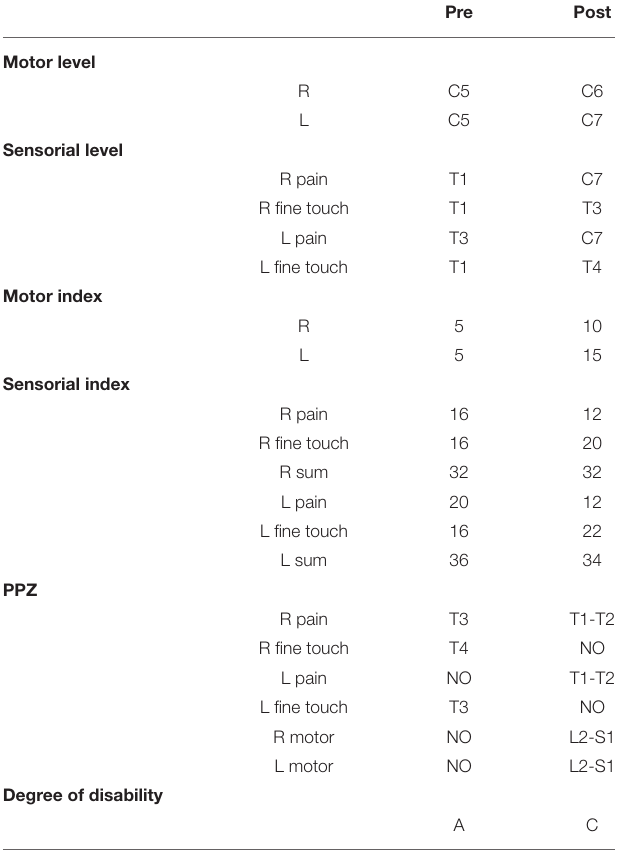
TABLE 2 | Values of the scores and variables of the American Spinal Injury Association (ASIA) assessment at the initial and final moments of treatment or pre- and